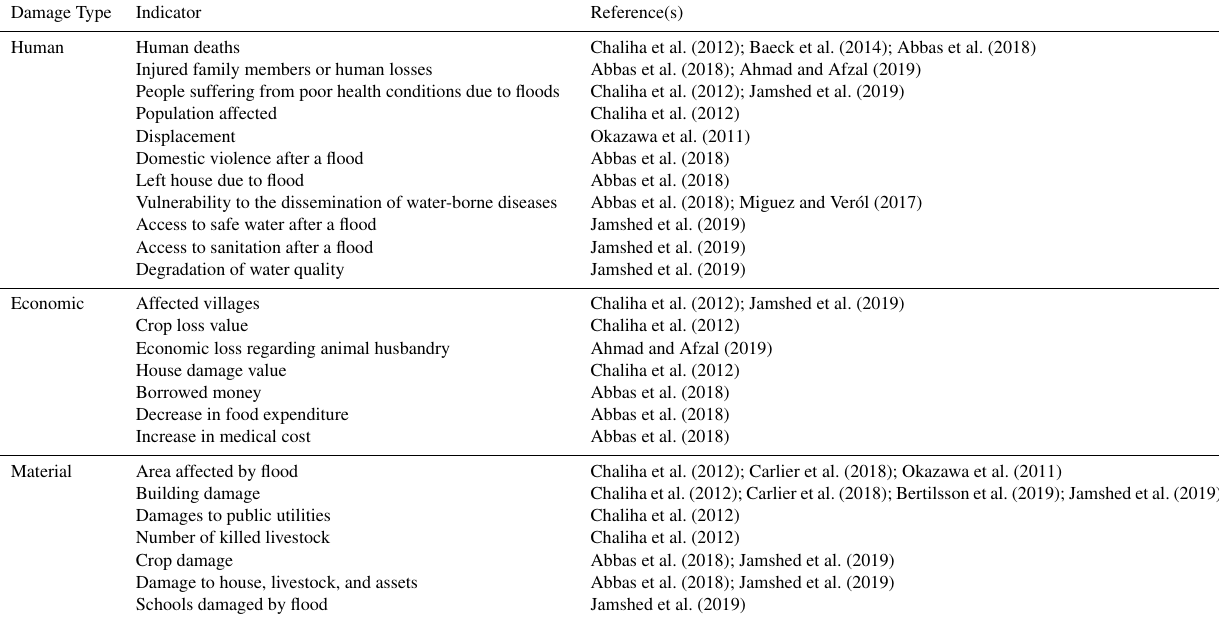
Table 5. Indicators used for flood vulnerability assessment through post-event